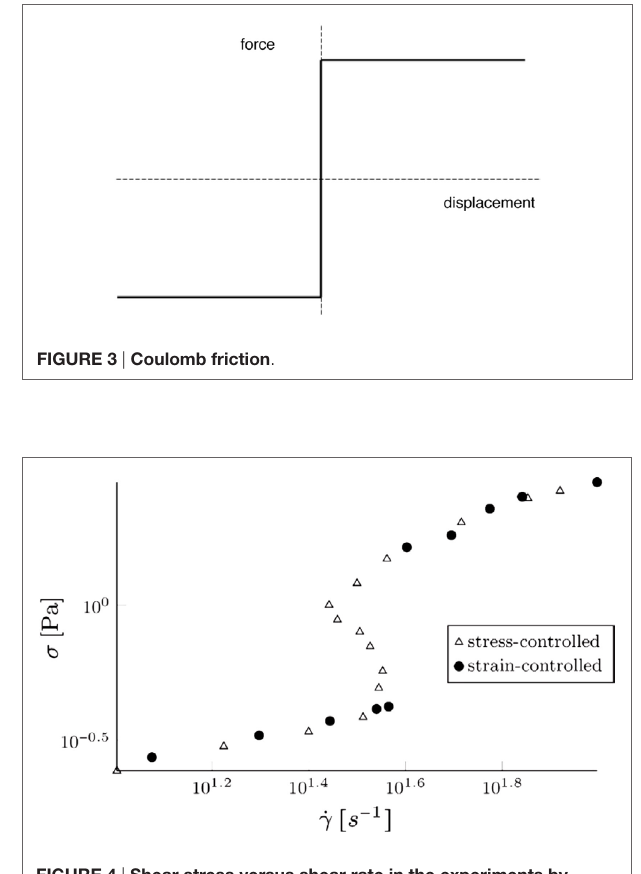
FigURe 4 | Shear stress versus shear rate in the experiments by Boltenhagen et al. (1997) for Tris(2-hydroxyethyl) tallowalkyl ammonium acetate (TTAA) surfactant dissolved in water containing sodium salicylate (NaSal) .